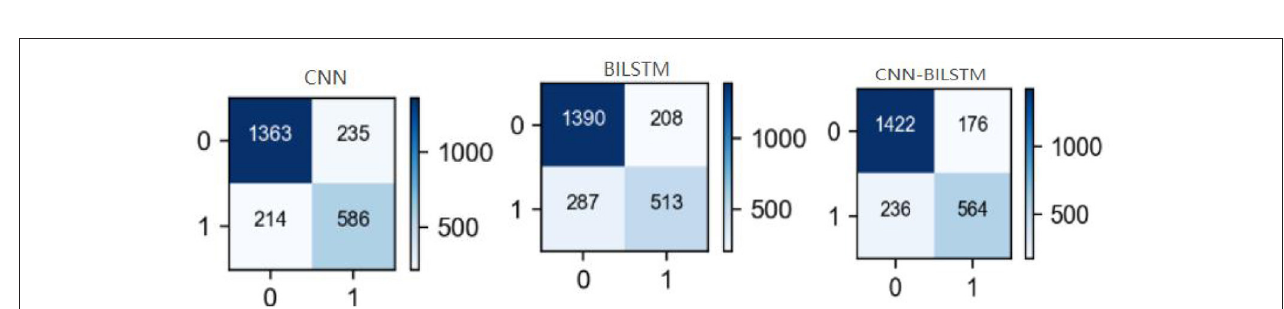
Frontiers in Public Health |